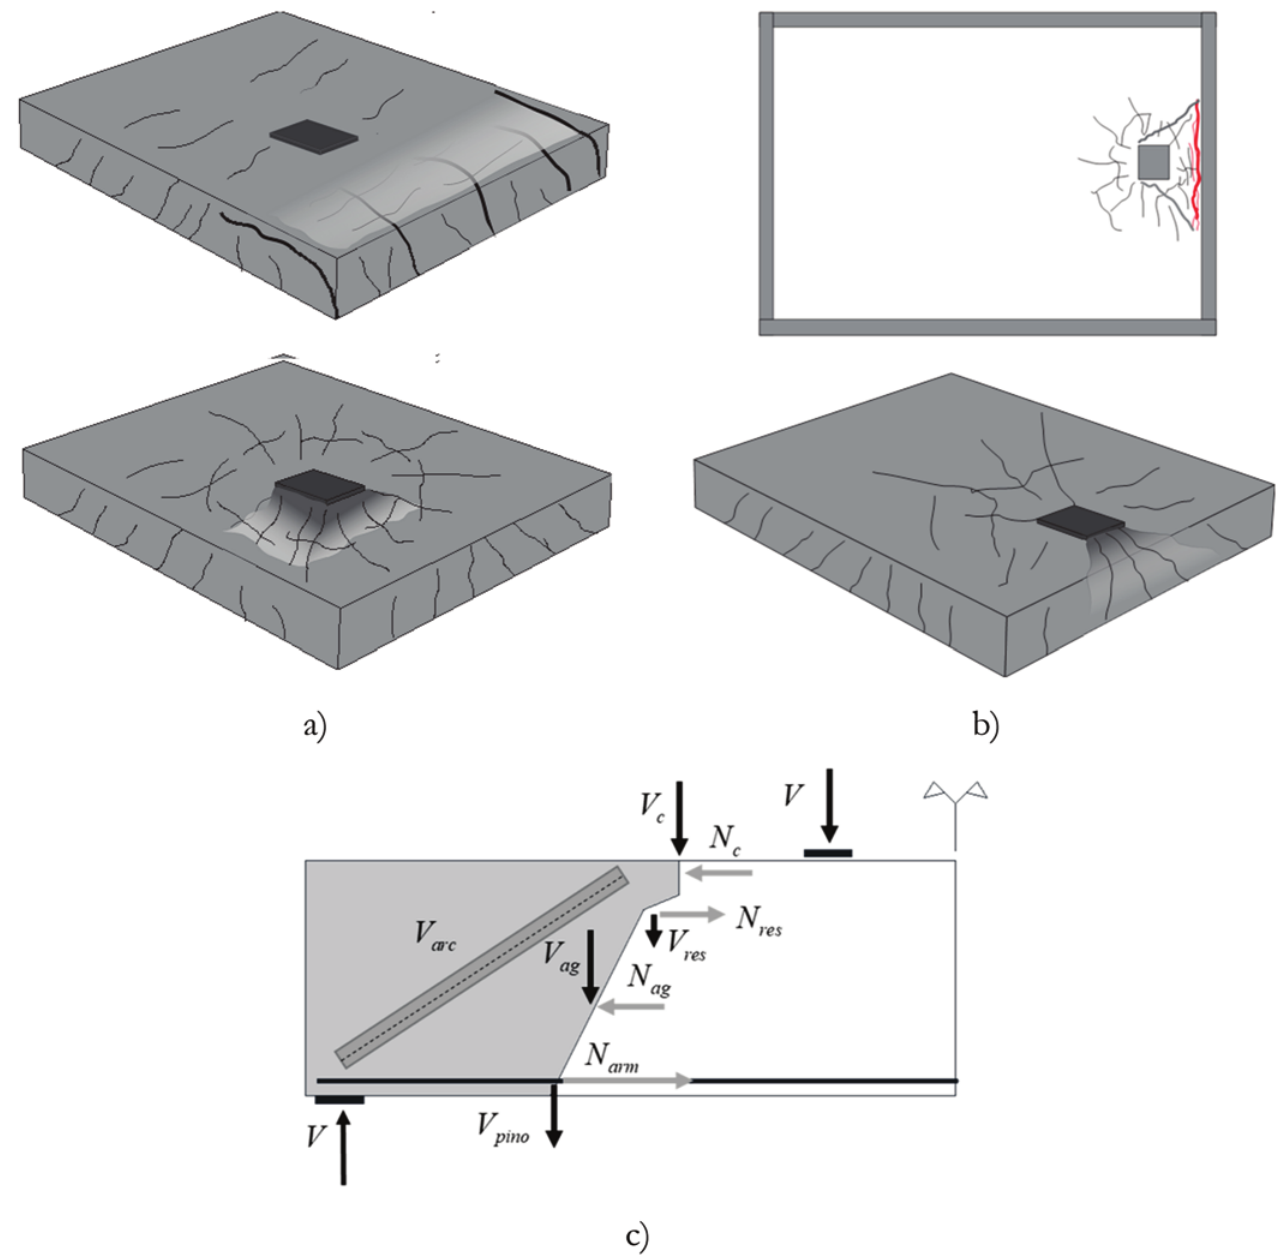
Figure 1 a) Failure mode by one-way shear in beams or slabs strips and two way shear by punching on slabs; b) failure mode as wide beam and c) Usual shear transfer